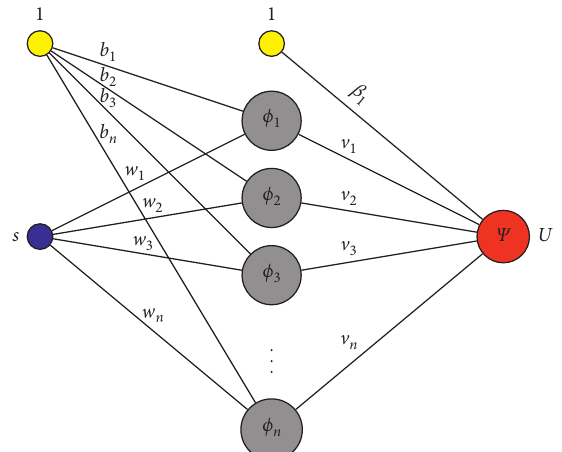
Figure 1: The topology of the network used for solving the Black–Scholes